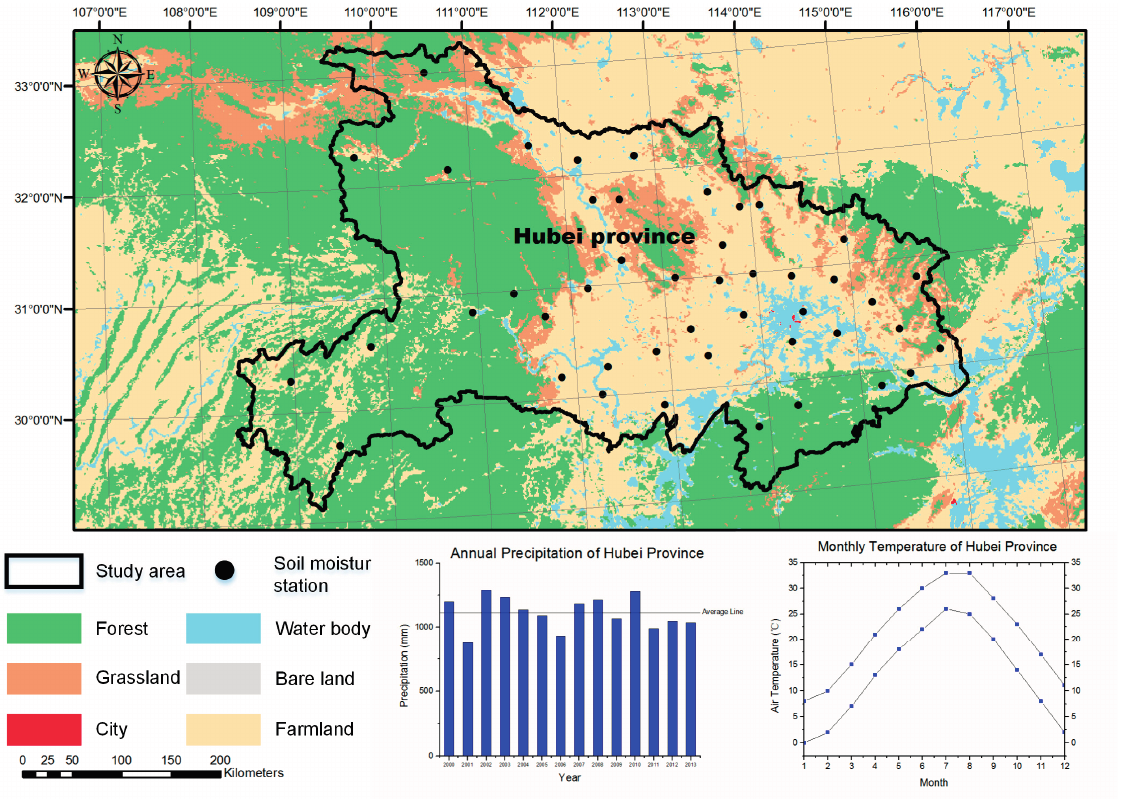
Figure 5. The experimental region (Hubei province) and land use. The western portion of Hubei province is covered by mountains and hills, and the eastern portion is covered by farmland. In addition, two rivers (Yangtze River and Hanjiang River) flow through this region. The black points indicate in situ meteorological stations for measuring soil moisture at the